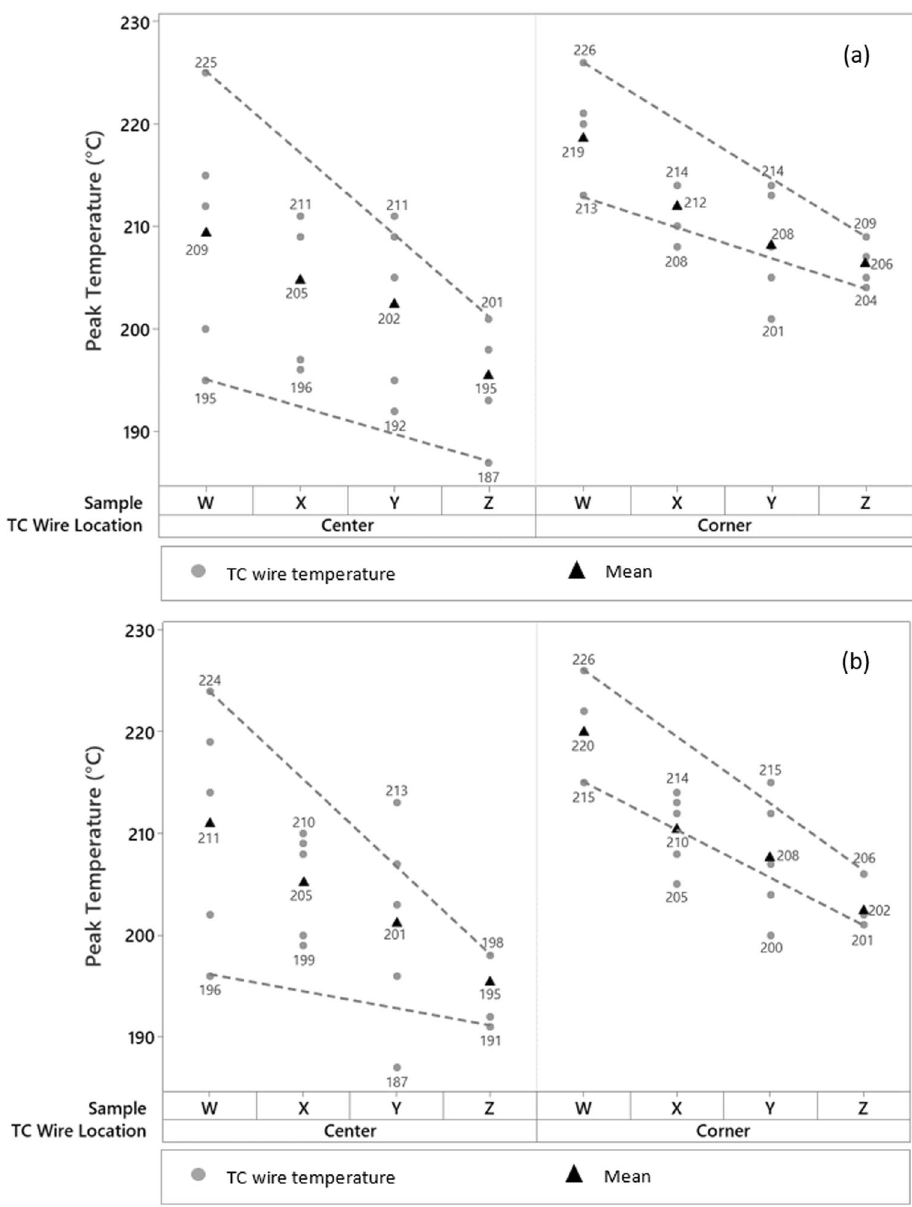
Figure 1. Variability chart for peak temperature on centre and corner of BGA for all samples: ( a )—top PCBA side; ( b )—bottom PCBA